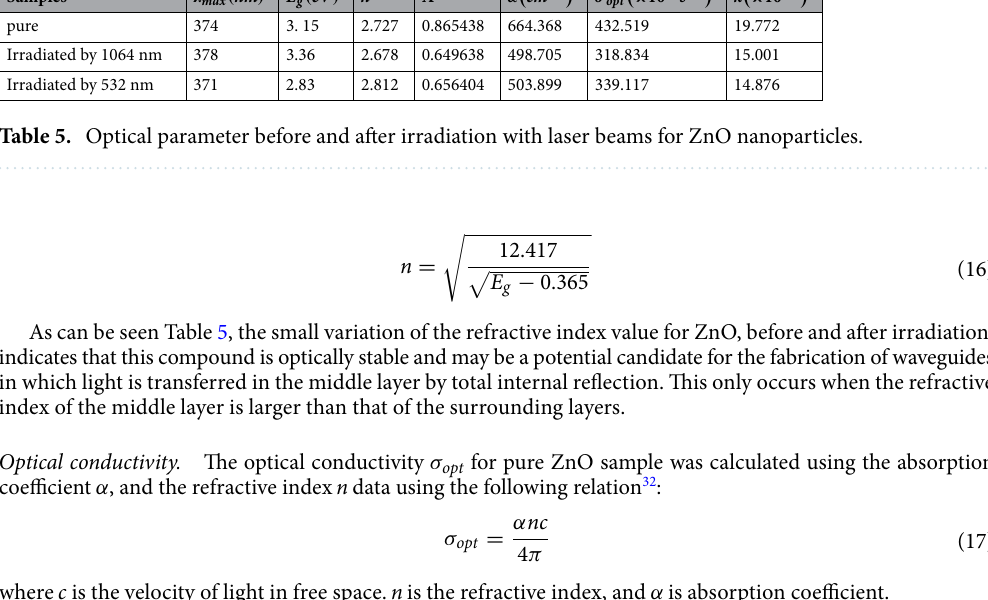
Table 5. Optical parameter before and after irradiation with laser beams for ZnO nanoparticles.